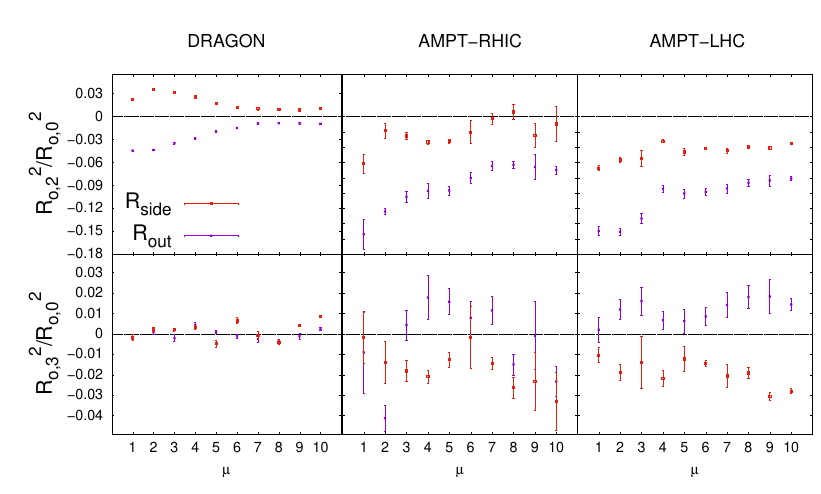
Figure 4. Scaled oscillation amplitudes for R 2 (lower row) for di ff erent event bins (they are plotted as functions of the event bin number). Simulations by DRAGON (left), AMPT for RHIC (middle) and AMPT for the LHC (right)